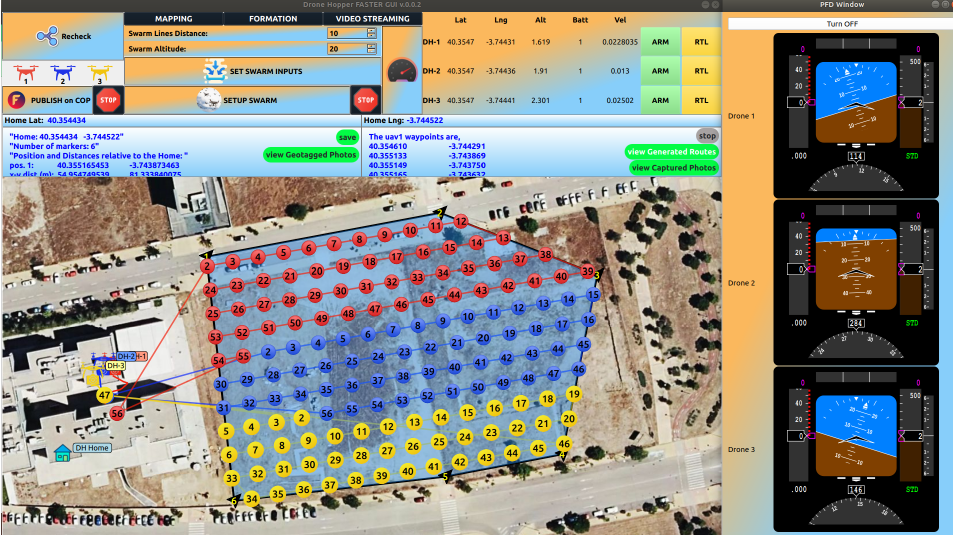
Figure 5. A snapshot of the ground control station (GCS) SW used for the swarm